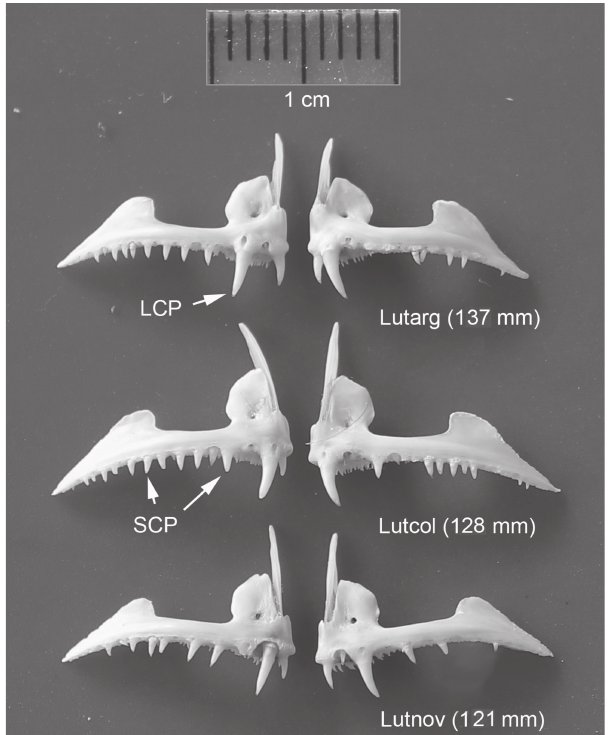
Fig. 3. Premaxillas of three species of snappers. In brackets, standard lengths of fish. LCP=Large canines in premaxillas; SCT=Smaller conical teeth in premaxillas. Lutarg: Lutjanus argentiventris ; Lutcol: Lutjanus colorado ; Lutnov: Lutjanus novemfasciatus